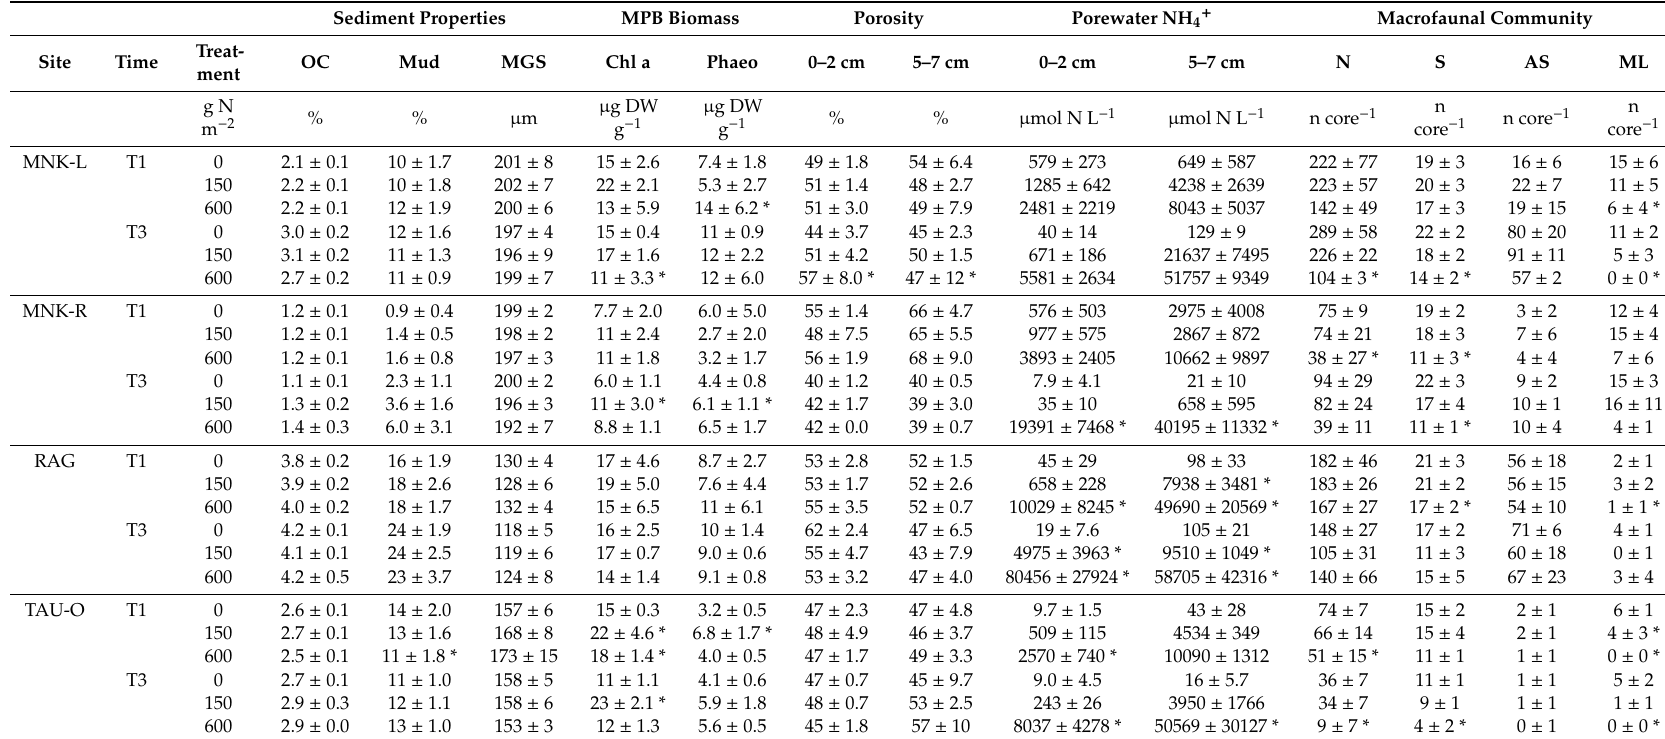
Table A2. Summary of sediment properties and univariate macrofaunal community indices as a function of site and nutrient enrichment treatment in November 2017 (T1) and November 2018 (T3). Data are displayed as mean ± SD. * indicates significant di ff erence from control ( p < 0.05). Di ff erences were tested using ANOVA with treatment as a fixed factor (3 levels) and Tukey post-hoc test, or for data not meeting the assumption of normality, a Kruskal-Wallis test followed by a Dunn post-hoc test in R